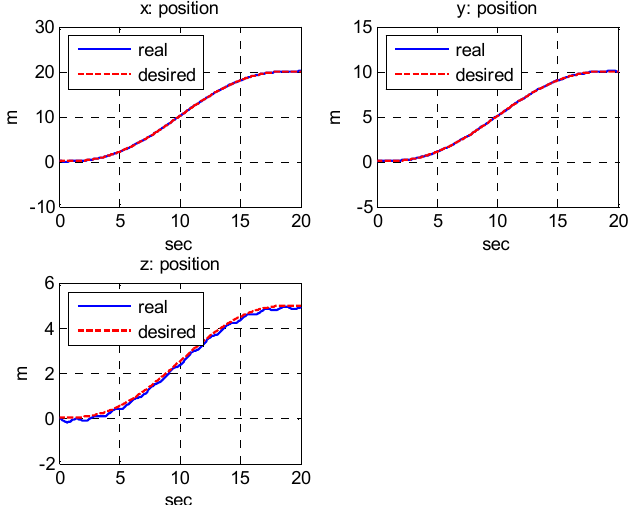
Figure 10. The position path with variable deviations and perturbations.